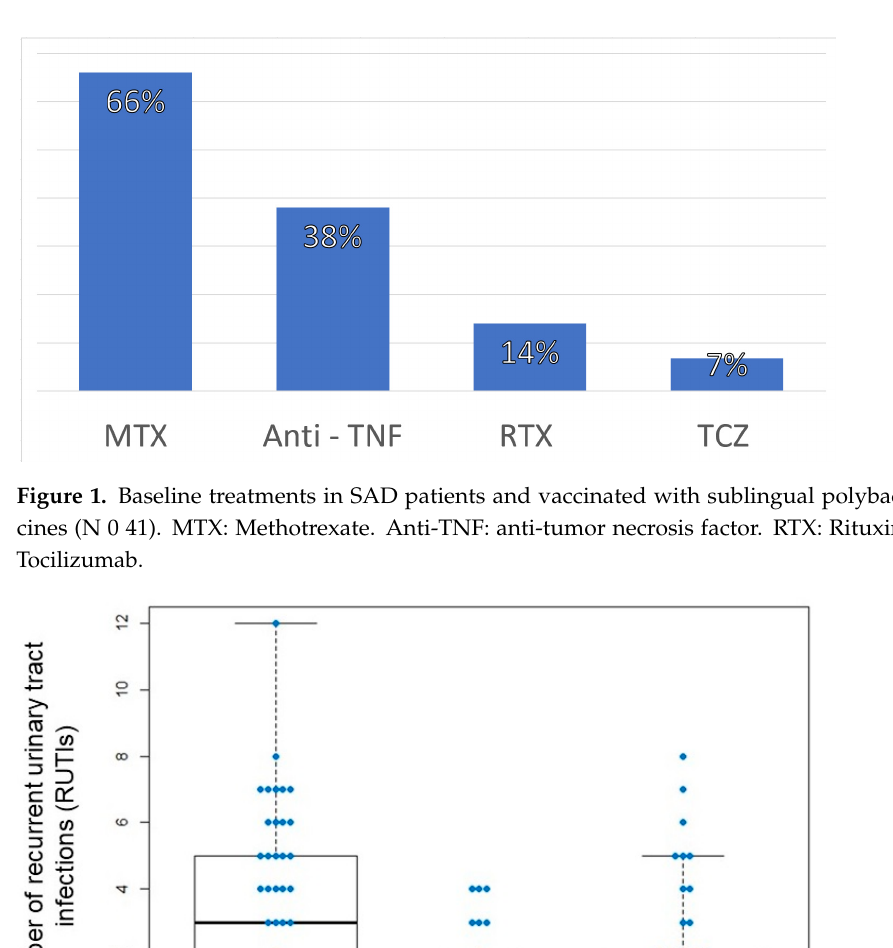
Figure 1. Baseline treatments in S(cid:31) D patients and vaccinated with sublingual polybacterial vaccines (N 0 41). MTX: Methotrexate. (cid:31) nti-TNF: anti-tumor necrosis factor. RTX: Rituximab. TCZ: Tocili- zumab.